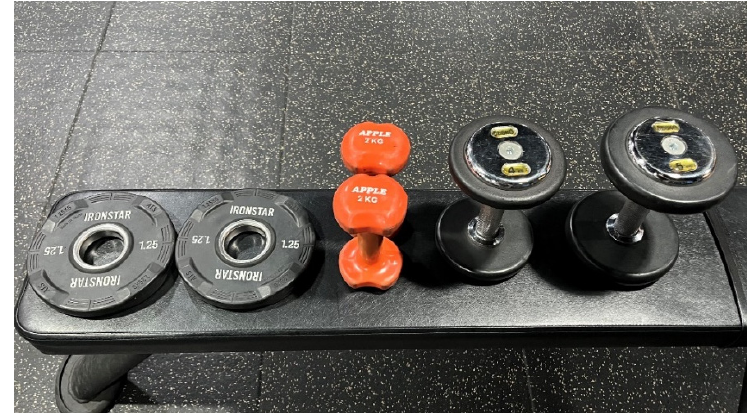
Figure 2. Five-step object image used in the experiment.